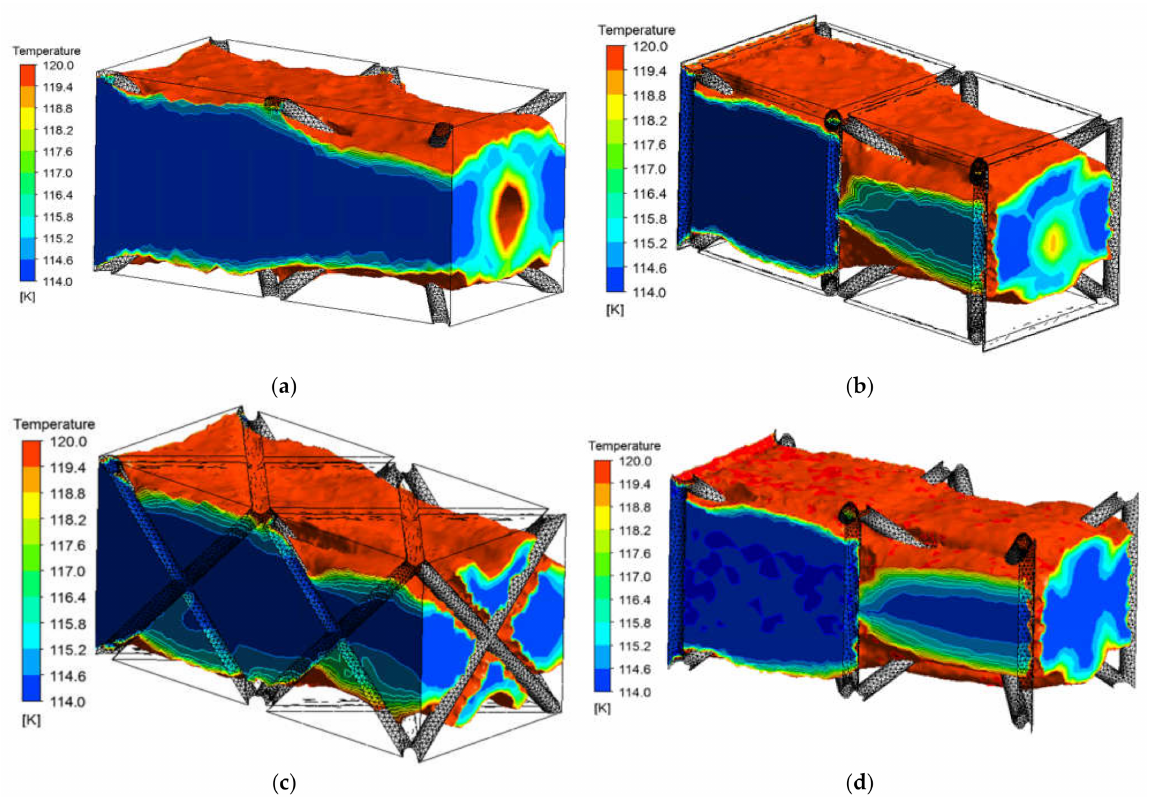
Figure 7. The isovolumes of the low-temperature fluid of each lattice: ( a ) X; ( b ) star; ( c ) cross; ( d ) tesseract. Figure 8 shows the volume ratio and relative density of the heated fluid in each lattice structure. Since the vortex intensities generated by the fluid passing through the cross type lattice and the tesseract type lattice are the lowest, the temperature increase of the fluid is the smallest. Considering the strength of the lattice structure and the temperature conductivity, the star type lattice cell is finally selected as the basic filling structure of the heat exchanger.